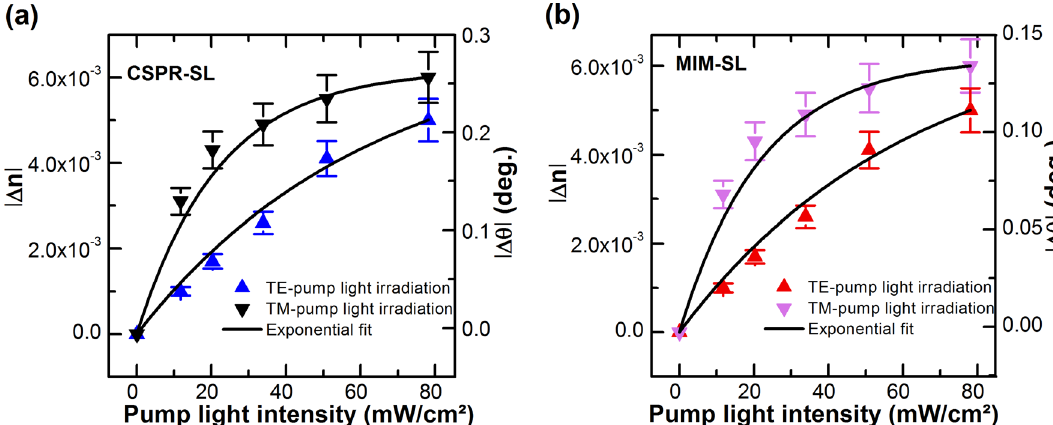
Figure 6. Photoinduced shift of ( a ) CSPR and ( b ) MIM sensors. The right vertical axis represents the shift in the resonance angle and the left axis represents the refractive index